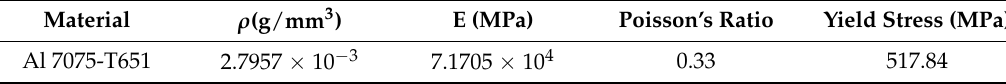
Table 1. Material properties of Al